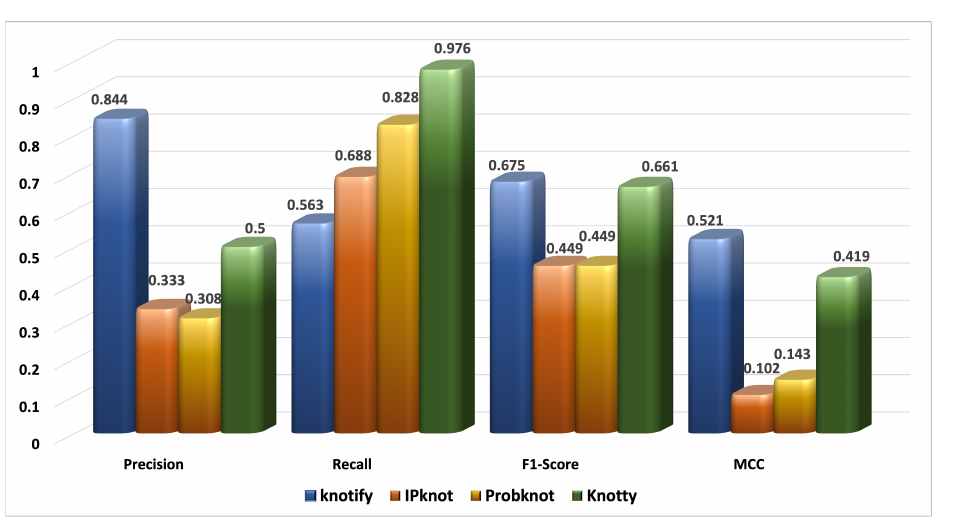
Figure 4. Precision, recall, F1-score, and MCC per